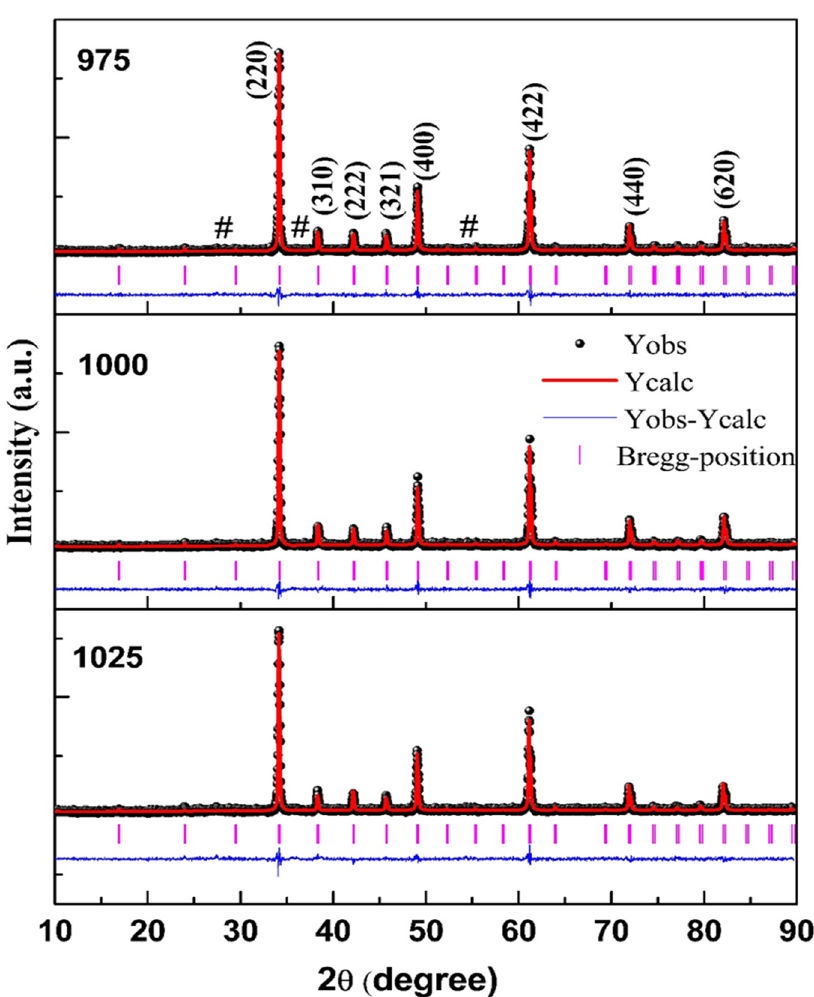
Figure 2. Rietveld refinement of XRD profiles of the LCTO CS-975, CS-1000, and CS-1025 ceramics. The reflections marked by # at 27.78°, ~36.2°, and 54.62° are corresponding to the impurity phase of tetragonal rutile TiO 2 phase (P42/mnm).